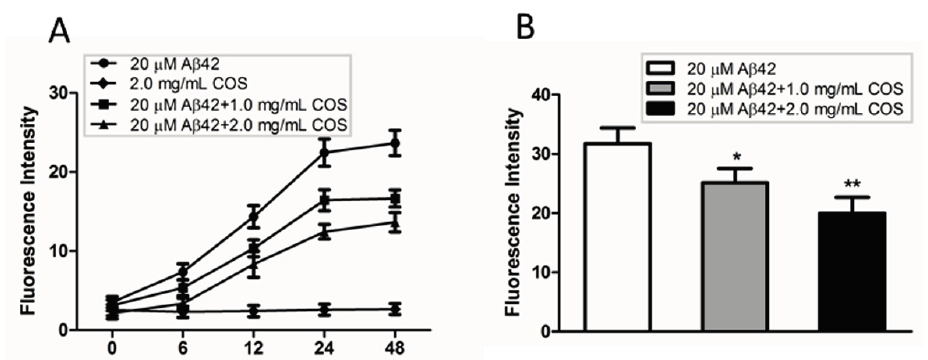
Figure 3. Effect of COS on A β fibrils formation. ( A ) Time-dependent thioflavin T (ThT) fluorescence intensity changes for 20 μ M A β 42 incubated with different concentration of COS (1.0 and 2.0 mg/mL respectively), as compared to 2.0 mg/mL COS or 20 μ M A β 42 alone; ( B ) Disaggregative effect of COS (1.0 and 2.0 mg/mL respectively) on preformed A β fibrils. Data were represented as mean ± SEM of three independent experiments. ** p < 0.01, * p < 0.05 vs. A β 42